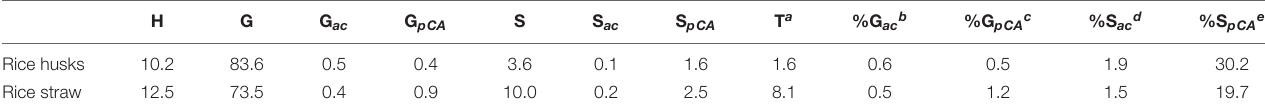
The percentages of the different acylated (acetylated and p-coumaroylated) lignin units are also shown. a T molar content referred as to the percentage of total lignin units (H + G + G ac + G pCA + S + S ac + S pCA = 100). b %G ac is the percentage of acetylated G units (G ac ) with respect to the total G units (G + G ac + G pCA ). c% G pCA is the percentage of p-coumaroylated G units (G pCA ) with respect to the total G units (G + G ac + G pCA ). d %S ac is the percentage of acetylated S units (S ac ) with respect to the total S units (S + S ac + S pCA ). e %S pCA is the percentage of p-coumaroylated S units (S pCA ) with respect to the total S units (S + S ac + S pCA